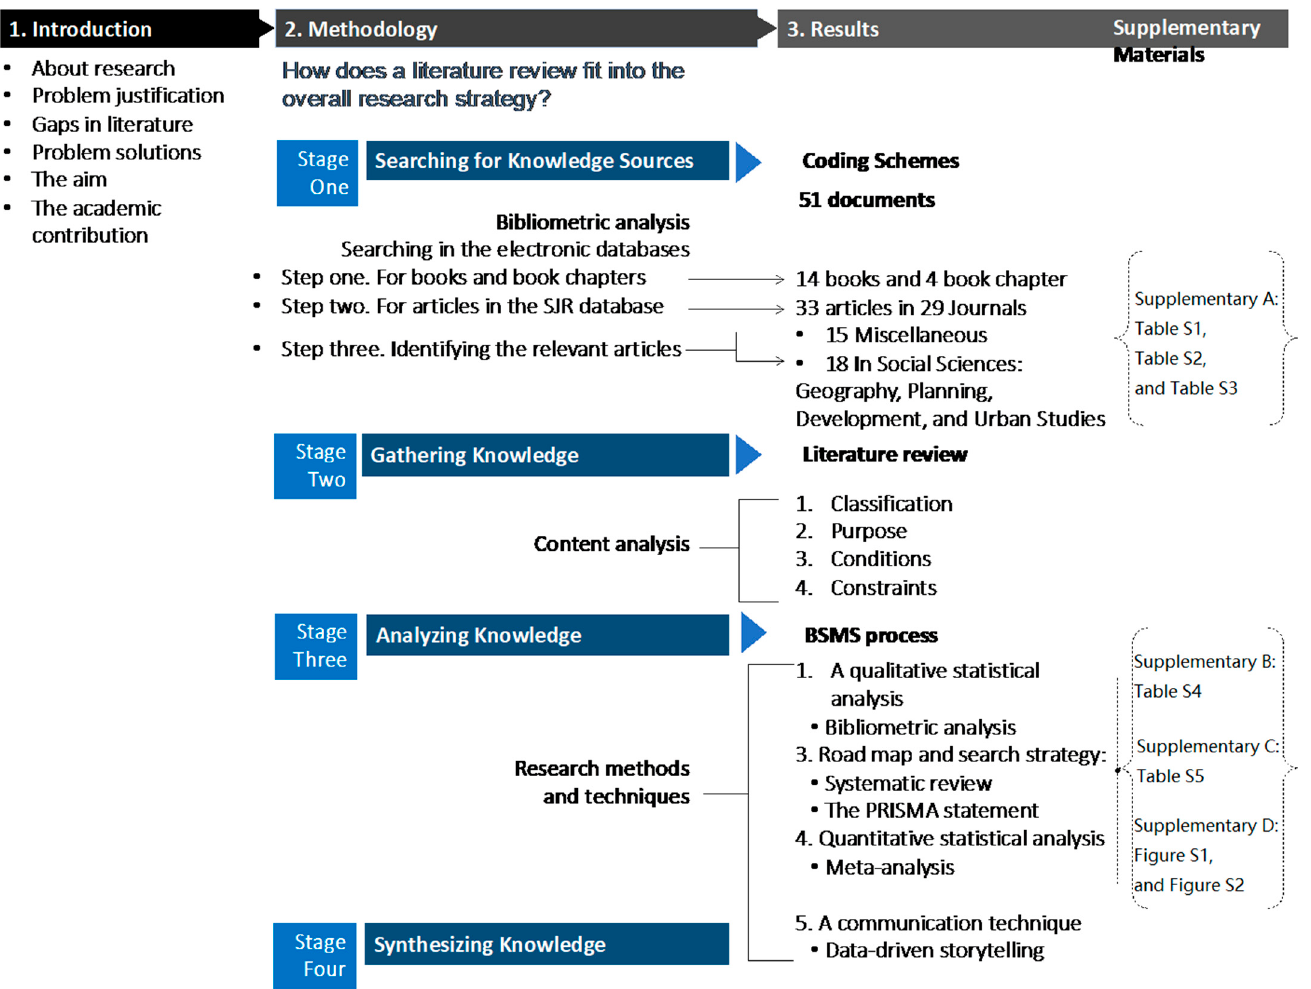
Figure 1. Research design.